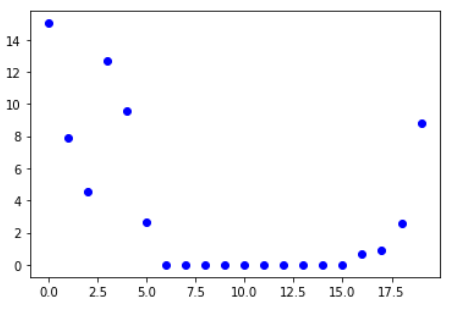
Figure 2. Display the error vector for one of the 252